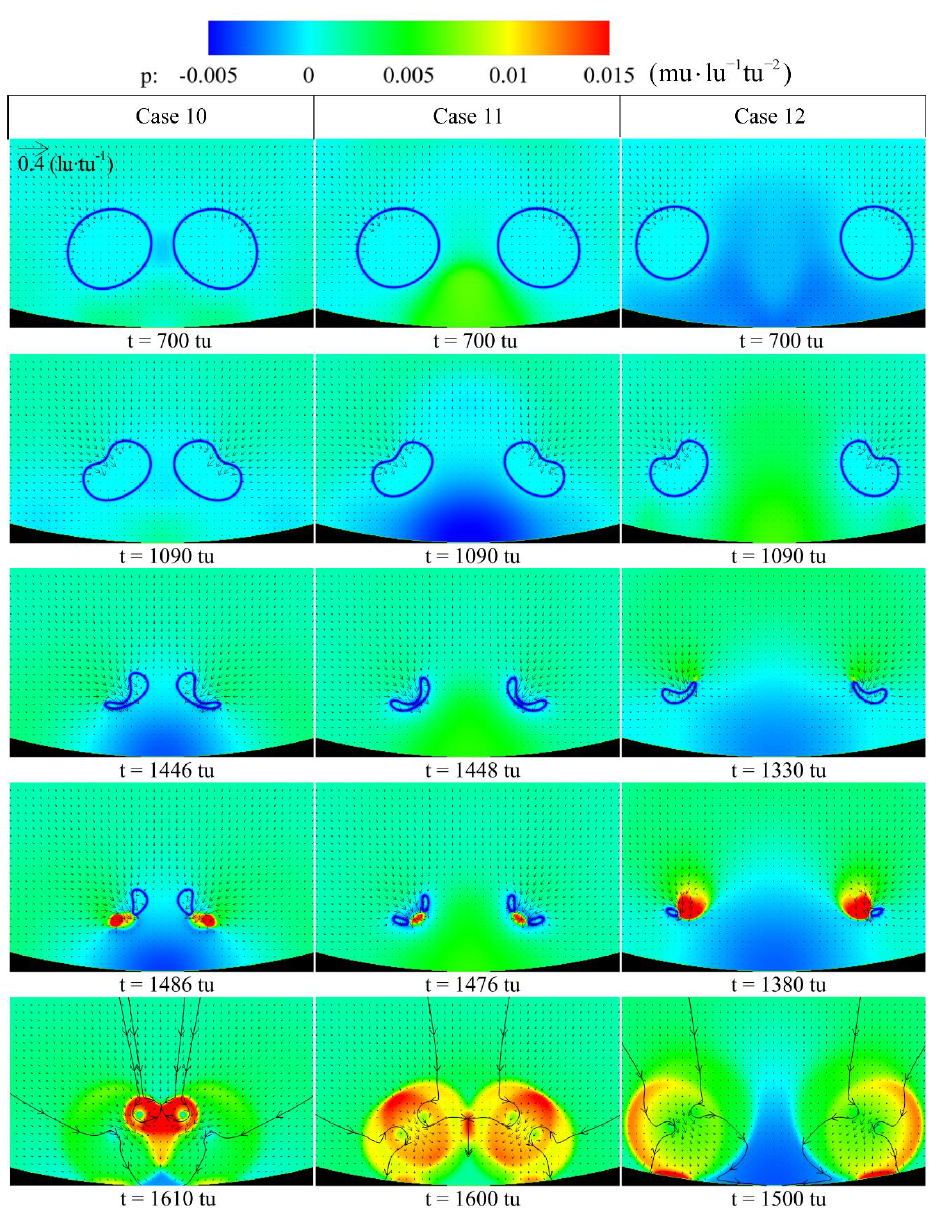
Figure 17. Pressure field and the velocity field of cavitation-bubble collapse in Cases 10–12.